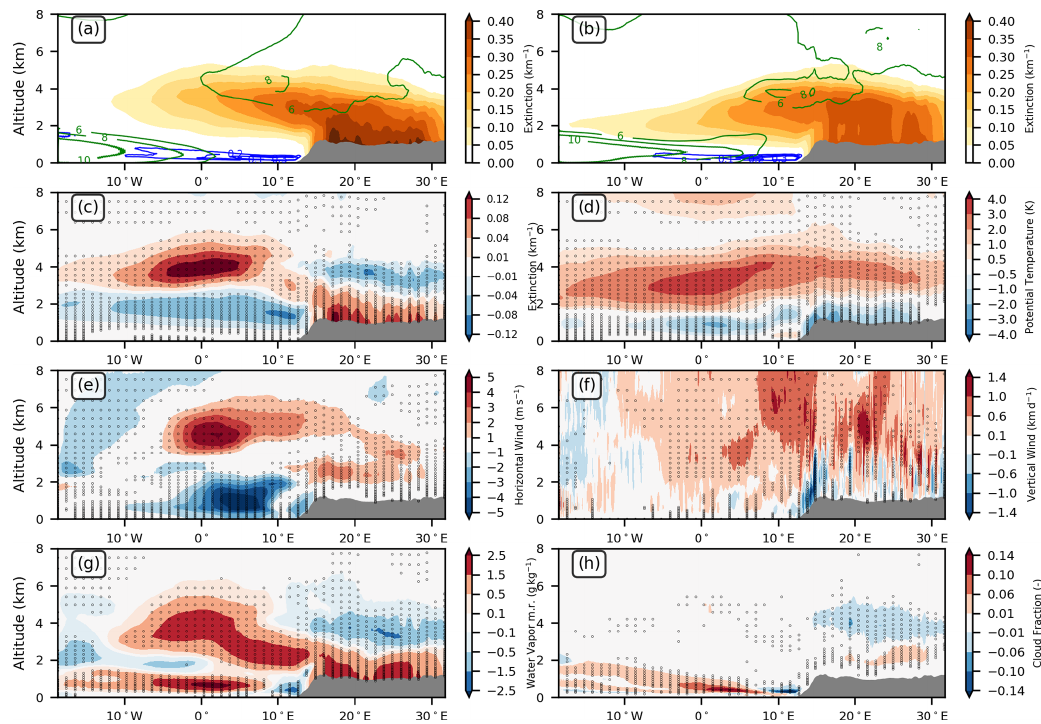
Figure 10. (a–b) Extinction (km − 1 , shading), horizontal wind speed (ms − 1 , green contour) and cloud fraction (blue contour) from the (a) BBRAD and (b) NORAD ensemble means. Changes between BBRAD and NORAD in (c) extinction, (d) potential temperature, (e) hor- izontal wind speed, (f) vertical wind, (g) water vapor mixing ratio and (h) cloud fraction. Black dots indicate where changes are statistically significant at the 0.05 level. Fields are averaged at 12:00UTC between 8 and 16 September 2017 and between 5 and 15 ◦